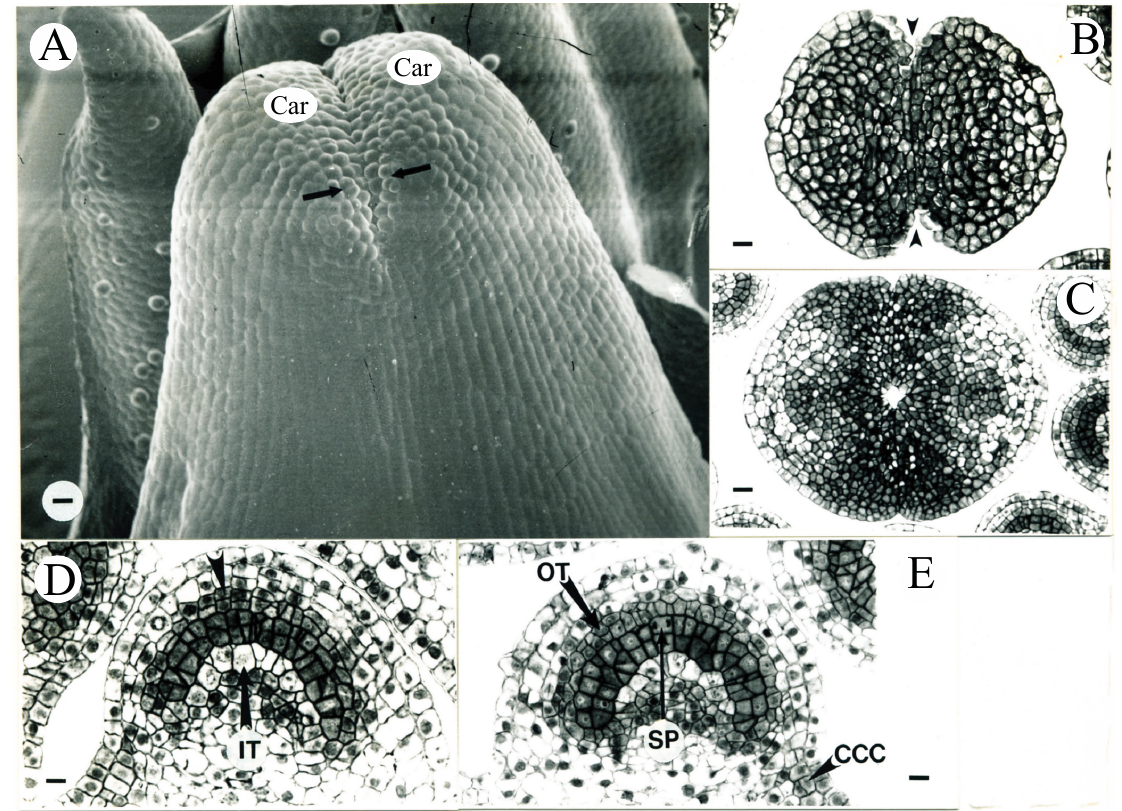
Figure 4. Tobacco pistil and anther development during the 6th day after ECP ( A )–( D ) and anther development during the 7th day ( E ) after ECP. ( A ) Carpels (Car) morphologically fusing in the top 5.4 days after ECP. The presence of the stigmatic papillar cells (arrows) indicates the differentiation of the stigma on the top portions of the carpels. Bar = 18 µ m. ( B , C ) Transverse sections of the same pistil seen in ( A ), showing the carpel epidermal cells have not de-di ff erentiated and carpel tips have not anatomically fused (between the arrowheads). Bars are 23.1 and 28.6 µ m in ( B ) and ( C ), respectively. ( D ) Transverse section of an abaxial microsporangium from an anther in the same flower shown in ( A ). The outer tapetum (arrowhead) starts to di ff erentiate. IT, inner tapetum. Bar = 12 µ m. ( E ) Transverse section of a representative adaxial microsporangium from the age interval 6.1 ± 0.6 days after ECP. The outer tapetum (OT) is now evident. Sporogenous tissue (SP; arrow) is in mitosis. The cells in the circular cell cluster (CCC, arrowhead) are evident. Bar = 16.7 µ m.